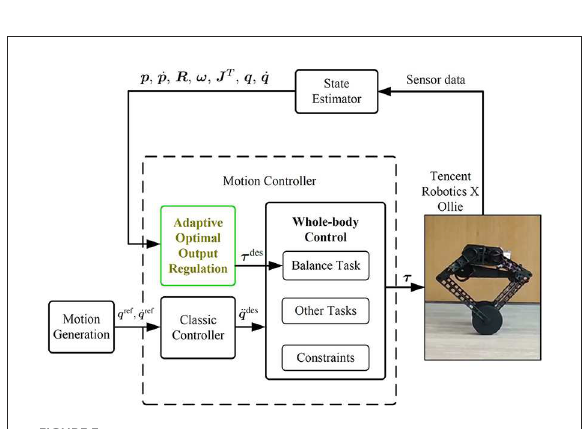
FIGURE3 Control framework of the robot